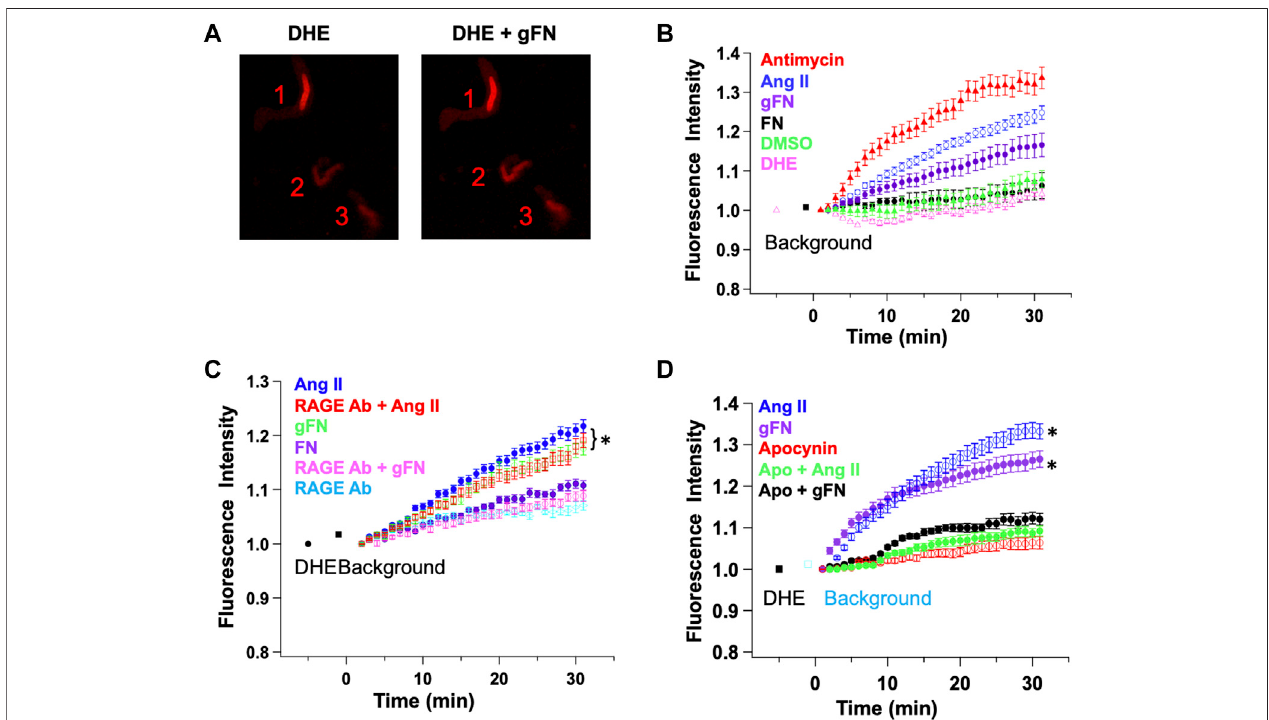
FIGURE 8 | gFN causes production of reactive oxygen species (ROS) in cerebral VSMCs as measured by dihydroethidium (DHE) fl uorescence. Panel (A) Representative confocal images before (DHE) and after (DHE + gFN) exposure of VSMCs to gFN. Panel (B) Time-dependent increase in ROS production is signi fi cantly greaterinresponsetogFN( n =6)comparedwithnativeFN( n =3).Antimycin(10 − 5 M; n =8)andangiotensinII(AngII;10- 7 M; n =6)wereusedaspositivecontrolsfor de novo ROSgeneration.DMSOtreatmentalonewasusedasavehiclecontrol.Panel (C) ROSproductioninresponsetogFNwasattenuatedbyanti-RAGEantibody whilethatoccurringinresponsetoAngIIwasnot.RAGEantibodyalonedidnotalter time-dependentincreasesinDHE fl uorescence.N=5 – 11cellspercondition.Panel (D) The NADPH oxidase inhibitor apocynin (5 × 10 − 4 M) reduced ROS production in response toboth gFN and Ang II.N = 5 – 9 cells per condition. Results are shown as mean ± SEM. * p < 0.05 (vs. RAGE Ab or treatment in the presence of apocynin).